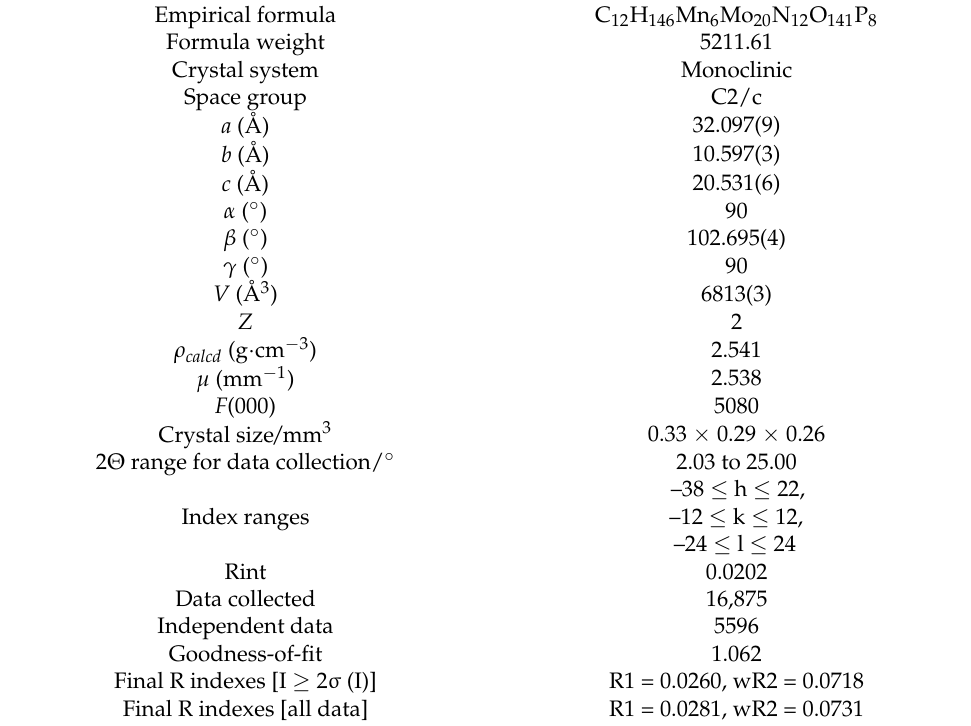
Table 2. Crystallographic data and structural refinements for